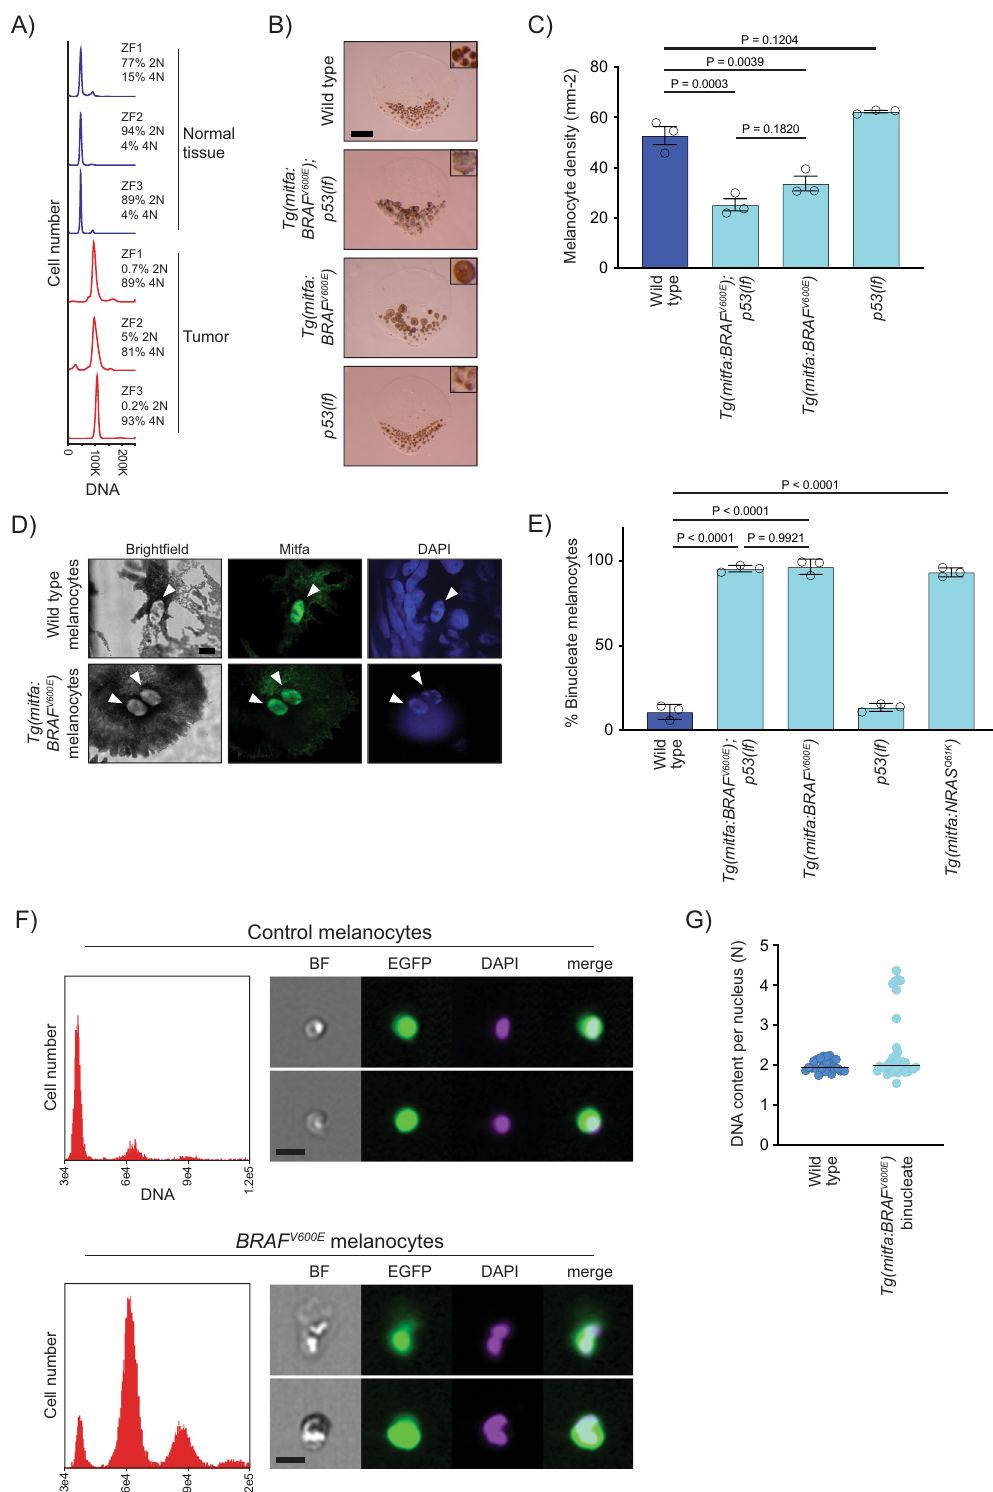
observed in zebra fi sh melanocytes that express an oncogenic variant of HRAS 45 . Together these data indicate that binucleate cells arise from overactivation of RAS/MAPK signaling. To examine ploidy of Tg(mitfa:BRAF V600E ) melanocytes, fl ow cytometry and DNA densitometry were performed. Zebra fi sh melanocytes retain melanin pigment, so an mitfa:EGFP transgene and albino mutation were introduced so that melanocytes could be